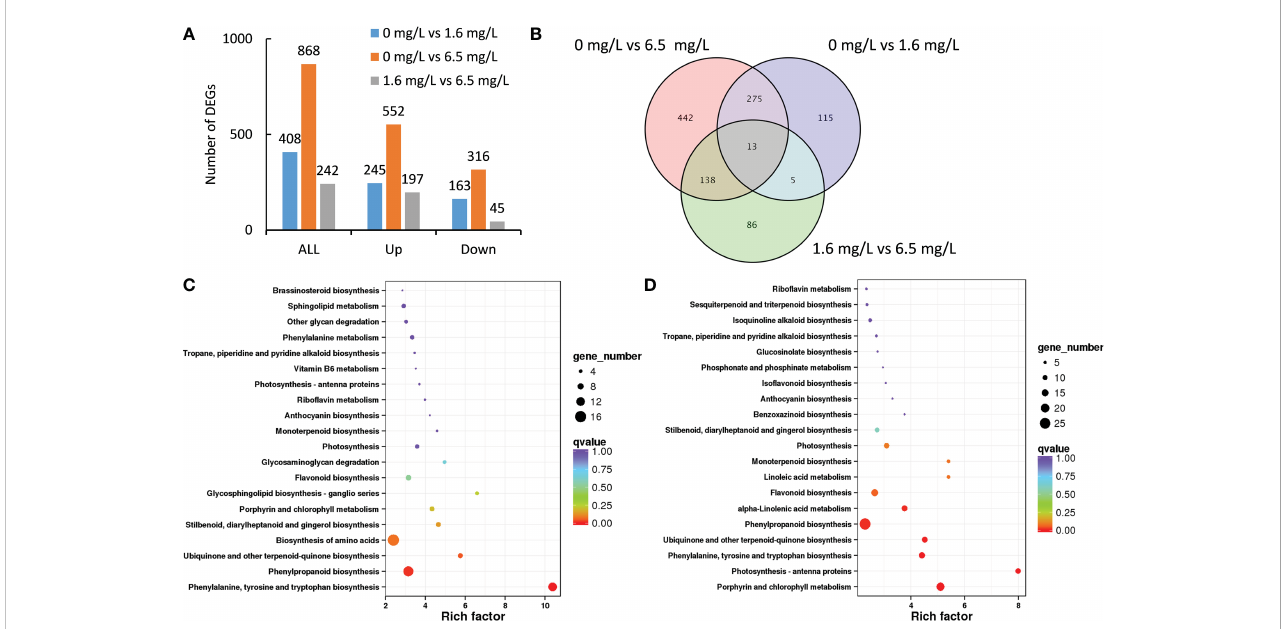
FIGURE 2 Transcriptomic pro fi les of peppermint leaf in response to low (1.6 mg L -1 ) and high (6.5 mg L -1 ) levels of Cd stress treatments at 24 h. (A) , the number of up- or down-regulated differentially expressed genes (DEGs); (B) , the venn diagram of DEGs; (C) , KEGG enrichment pathway of DEGs from the comparison of 0 mg L -1 Cd treatment vs 1.6 mg L -1 Cd treatment; (D) , KEGG enrichment pathway of DEGs from the comparison of 0 mg L -1 Cd treatment vs 6.5 mg L -1 Cd